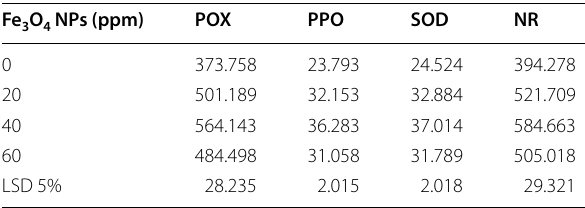
O NPs on Table 5 Effect of foliar application with Fe 3 4 enzymes POX, PPO, SOD (U/min/g FW) and NR (nM NO of Moringa oleifera L.